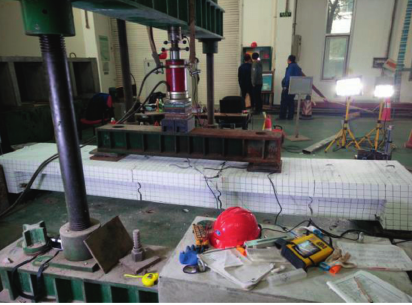
Figure 3: Two-point loading.